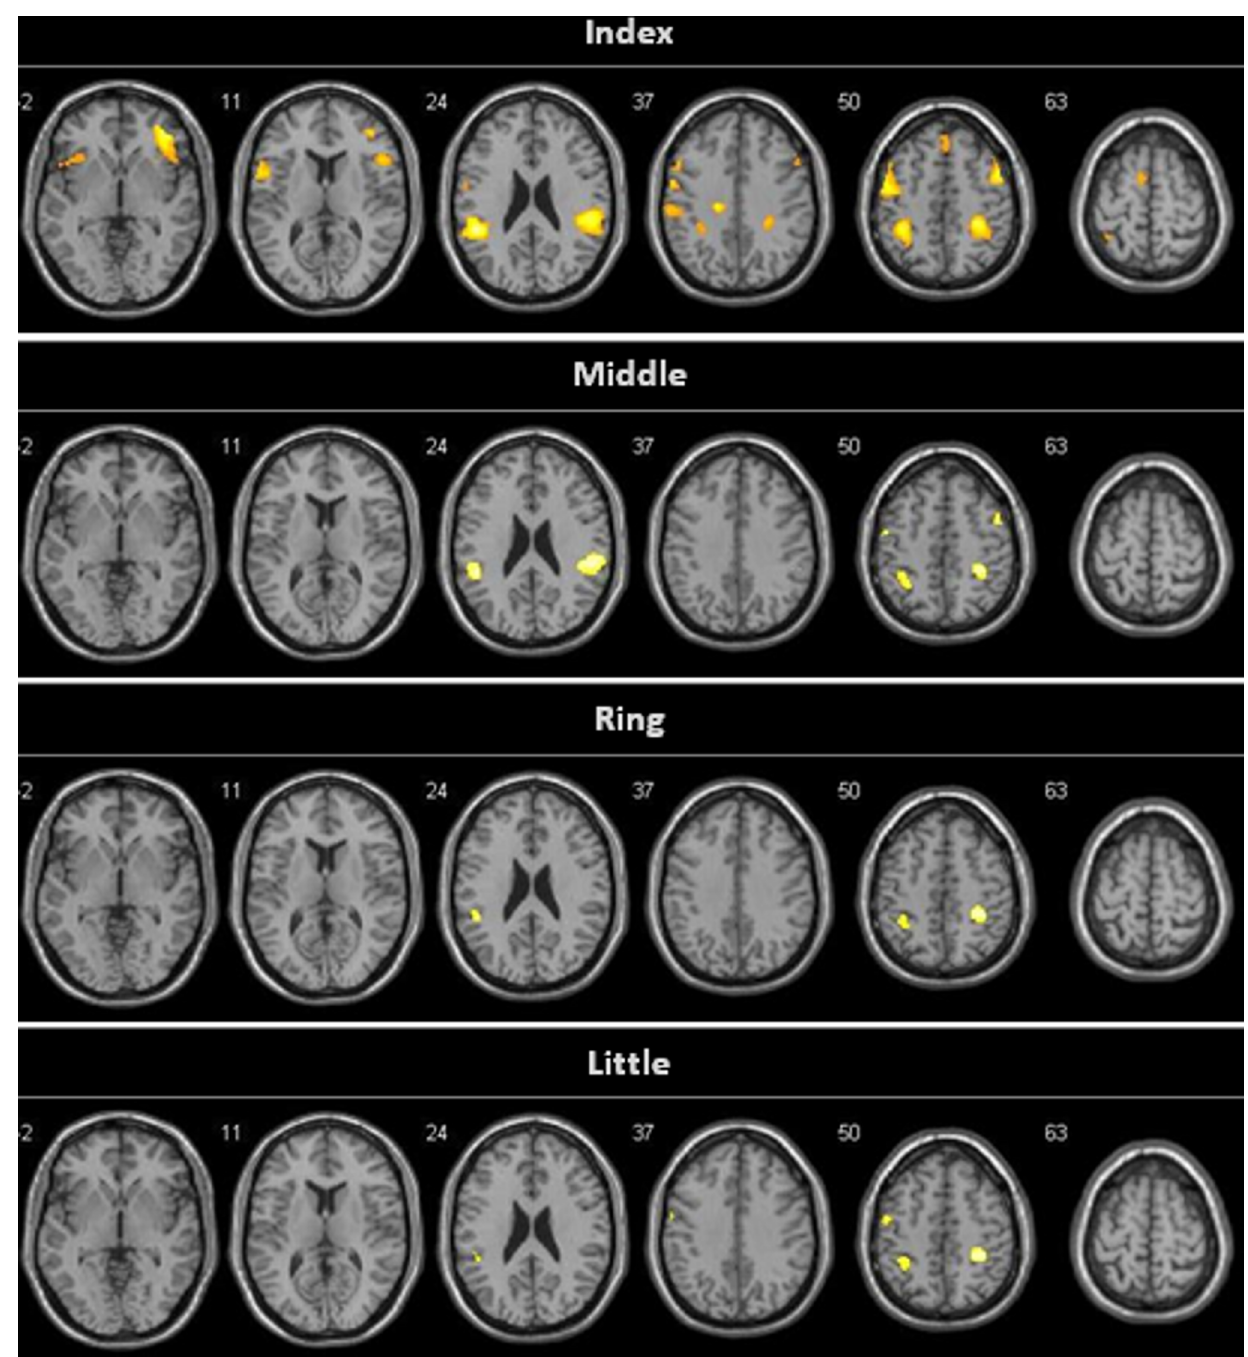
Figure 3. Brain activation pattern during the different finger to thumb opposition task observation. The main activation during the observation of index - thumb opposition task appears in premotor and parietal areas. As the effector finger gets further away from the thumb, the observation of the opposition task leads to a lesser activation in frontal and parietal areas. Threshold: p=0.01, FDR; k=20.